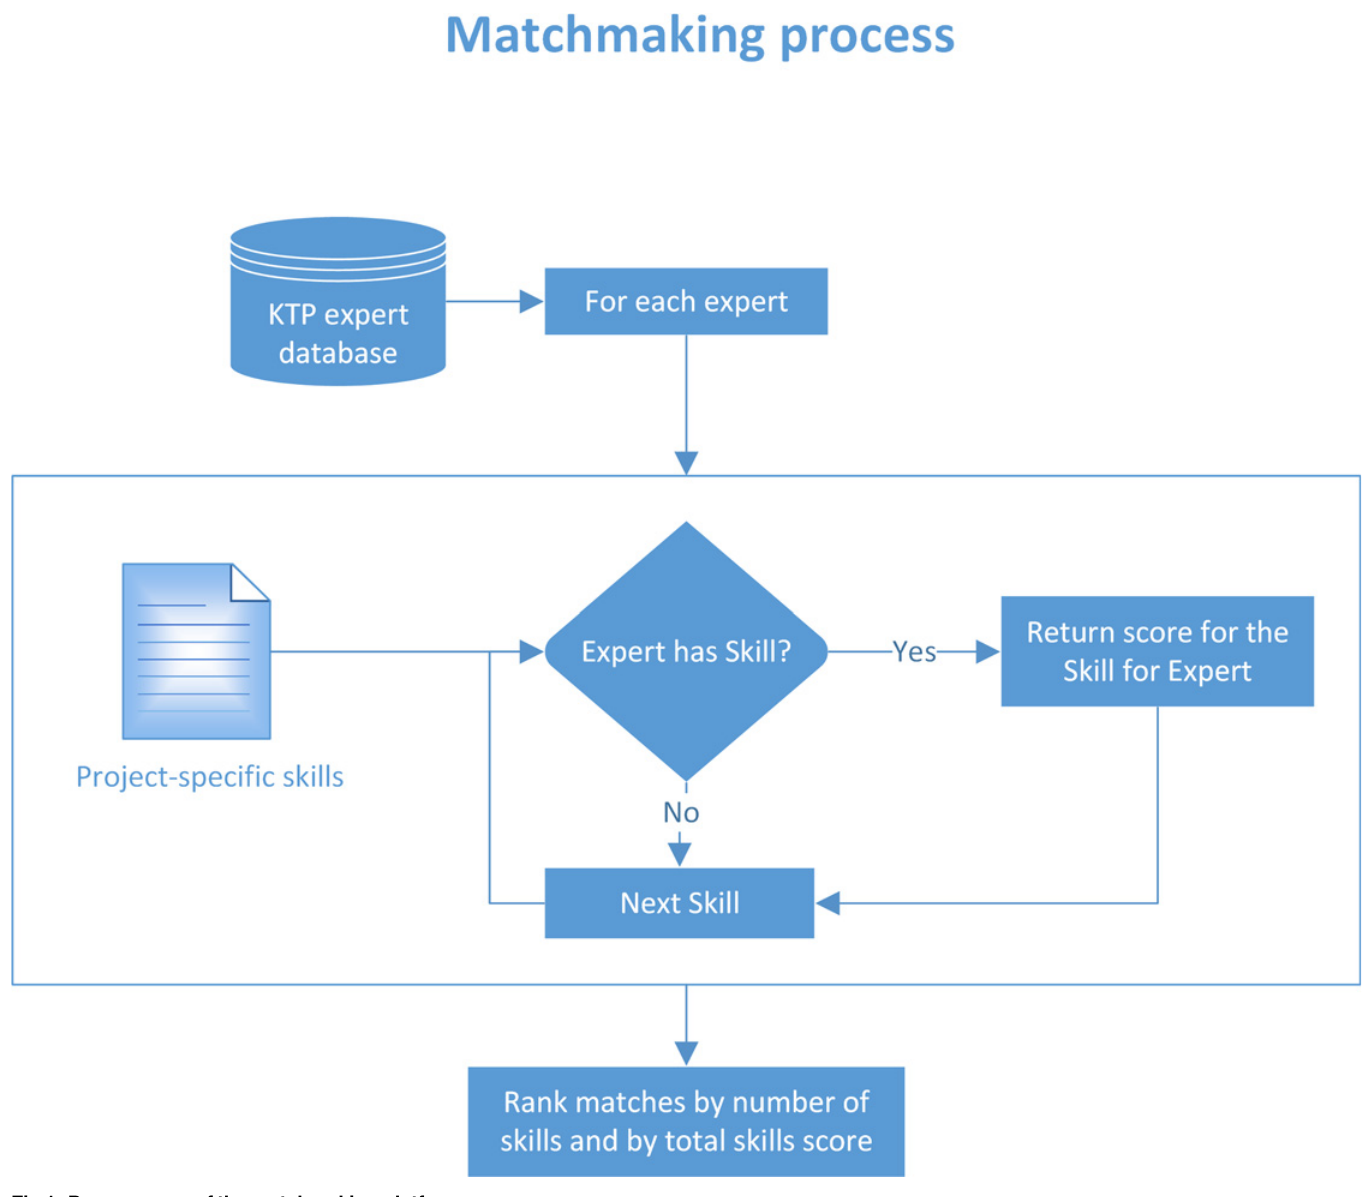
Fig 1. Process map of the matchmaking